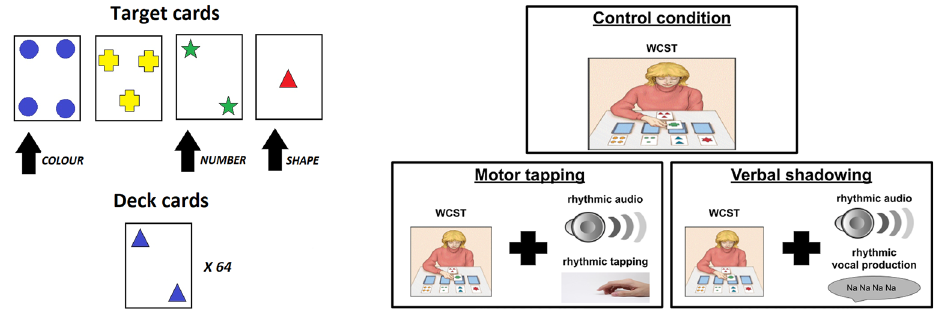
Figure 1. Left: WCST setting; the black arrows indicate the target cards that correspond to a certain category that matches the category of the shown deck card. Right: Experimental protocols used to test the model, involving the basic WCST (control), and a WCST where the participant has to perform a rhythmic tapping following a rhythmic audio, and a critical analogous verbal-shadowing condition affecting inner